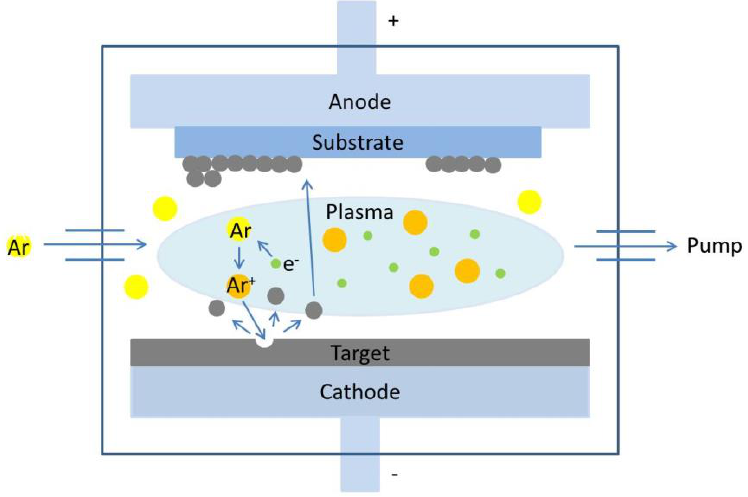
Figure 4. Schema of a RF-sputtering chamber.